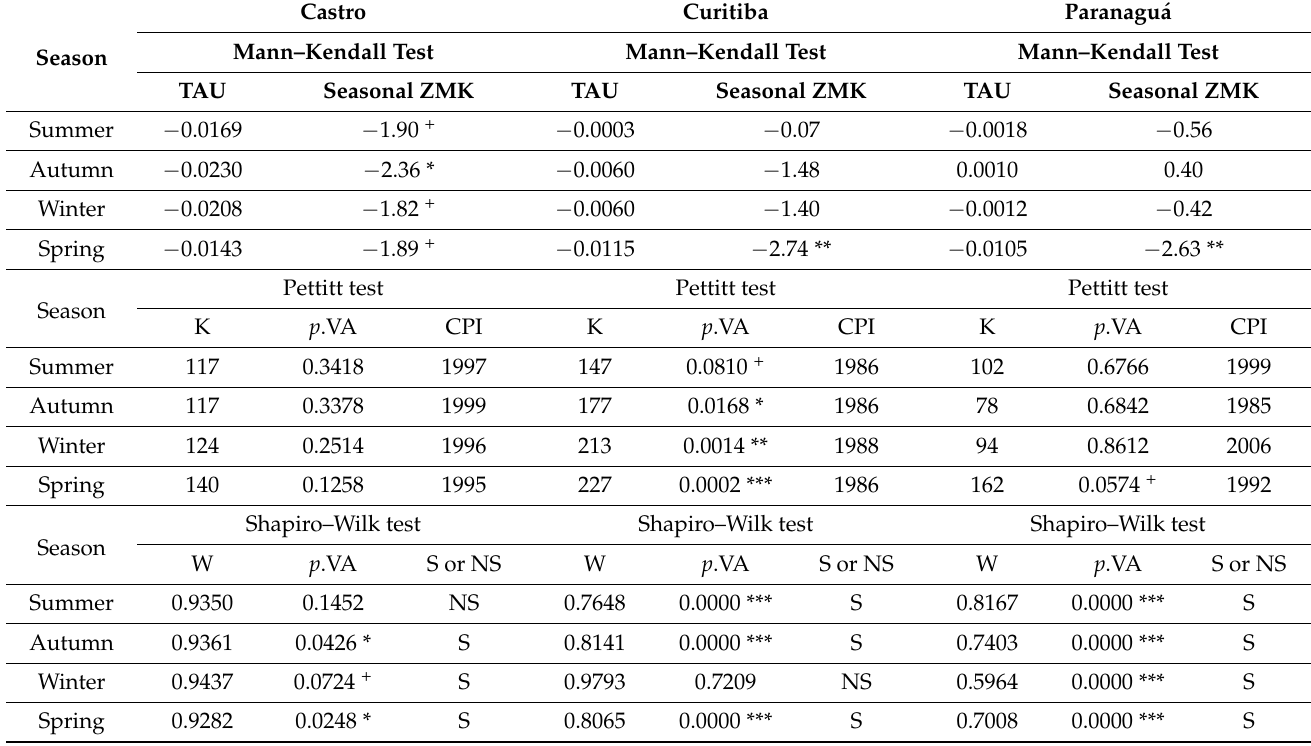
Table 5. Seasonal wind speed trend (ZMK) according to the Mann–Kendall test, change point detection (CPI) of the Pettitt test, and normality of the Shapiro–Wilk parametric